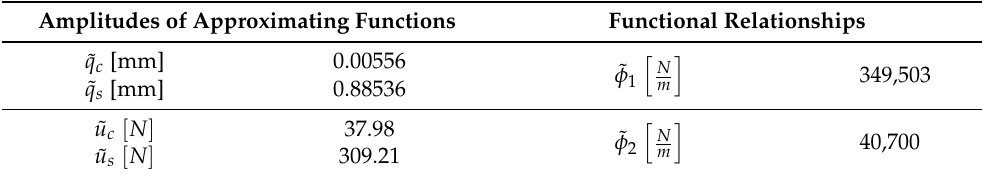
Table 1. The results of the approximation of laboratory measurements ( λ = 140 rad/s).